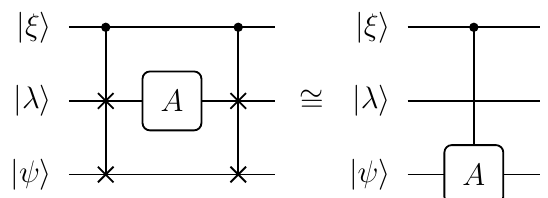
FIG. 5. The construction of | 1 (cid:6) -controlled- A (for A a single- qubit operator) given access to | λ (cid:6) a ( + 1 ) eigenvector of A , | ξ (cid:6) the control qubit, and | ψ (cid:6) the target state. Note that A may in general act on a large Hilbert space, in which case the controlled- swap operator is suitably generalized. The swaps can be made | 0 (cid:6) controlled to emulate Fig. 4. We note that this is a similar con- struction to the circuits employed in Ref. [40] for matrix element